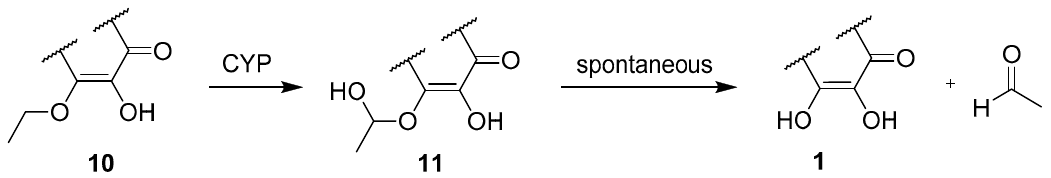
Figure 3. Mechanism for the CYP-mediated reversion of the 3- O -ethyl VC derivative to VC . Partial structures are shown.